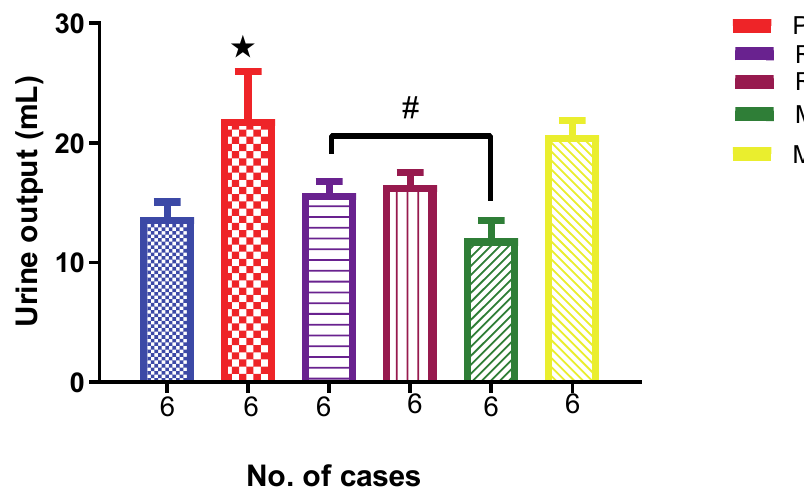
Figure 11. Urinary output volume in normal control (NC), prediabetic control (PD), metformin and diet intervention (MET + DI), metformin and high-fat/high-carbohydrate diet (MET + HFHC), rhenium (V) compound and diet intervention (Re + DI) and rhenium (V) compound and high- fat/high-carbohydrate diet (Re + HFHC) groups after 12 weeks of treatment. Values are presented as means ± SEM (n = 6). (cid:70) p < 0.05 in comparison with NC; # p < 0.05 in comparison with PC, MET + DI, MET + HFHC, Re + DI and Re +